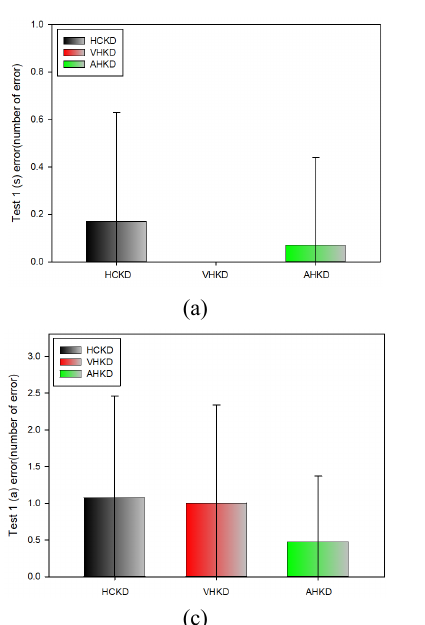
Figure 14. Frequency of error occurrence in Test 1(*: p <